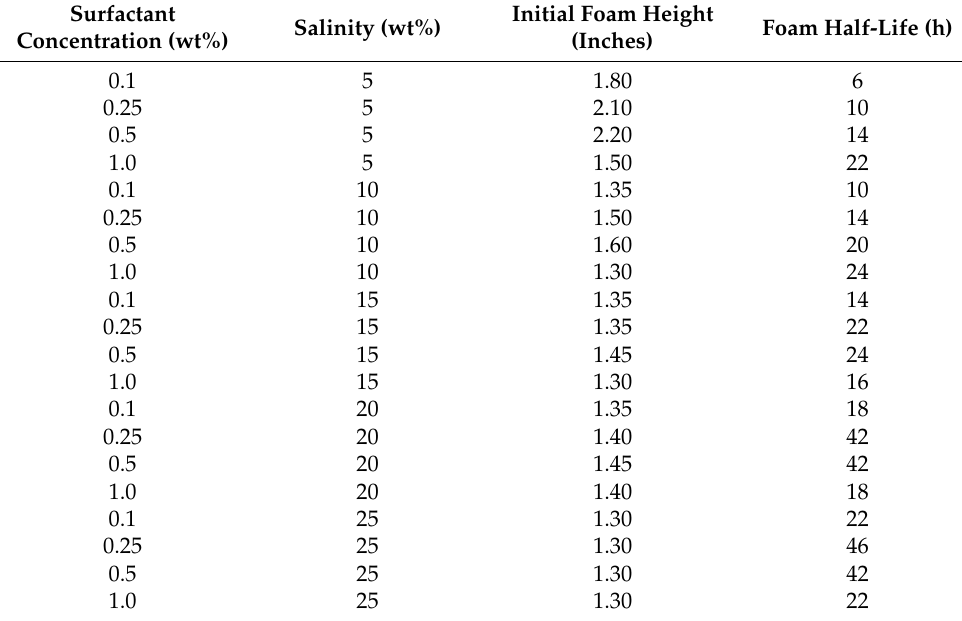
Table 1. Foam half-life of EC12 at room temperature and pH 6.5.